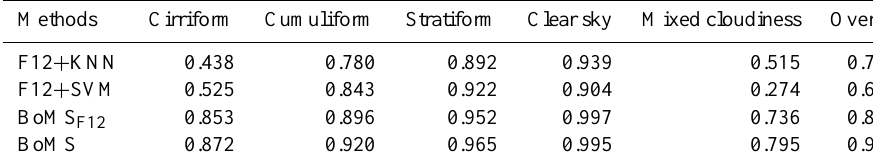
Table 3. Comparison of BoMS and baselines according to accuracy of each class.